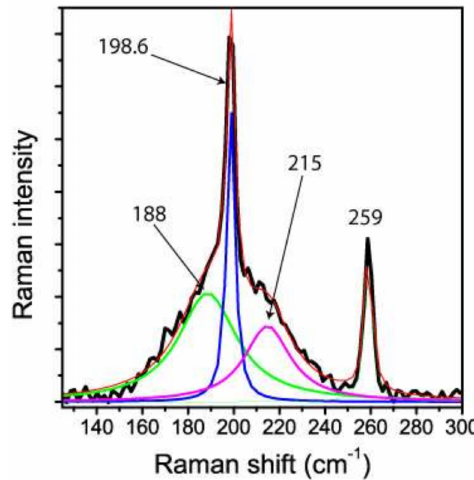
Figure 5. Raman spectrum of hydrous stishovite around the ν 1 band from the first measurement. The broadening of this band in the lower part of Figure 4 can be traced back to frozen components at higher pressure. According [17], the band at 188 cm − 1 corresponds to a pressure of 46.9 GPa, and the component at 215 cm − 1 to a pressure of 17.8 GPa. The large values for the Full Width at Half Maximum (FWHM) of 58 and 22 cm − 1 , respectively, reflect the strong anisotropic behavior of this stishovite mode under pressure, and show that the frozen state does not represent a sharp, single